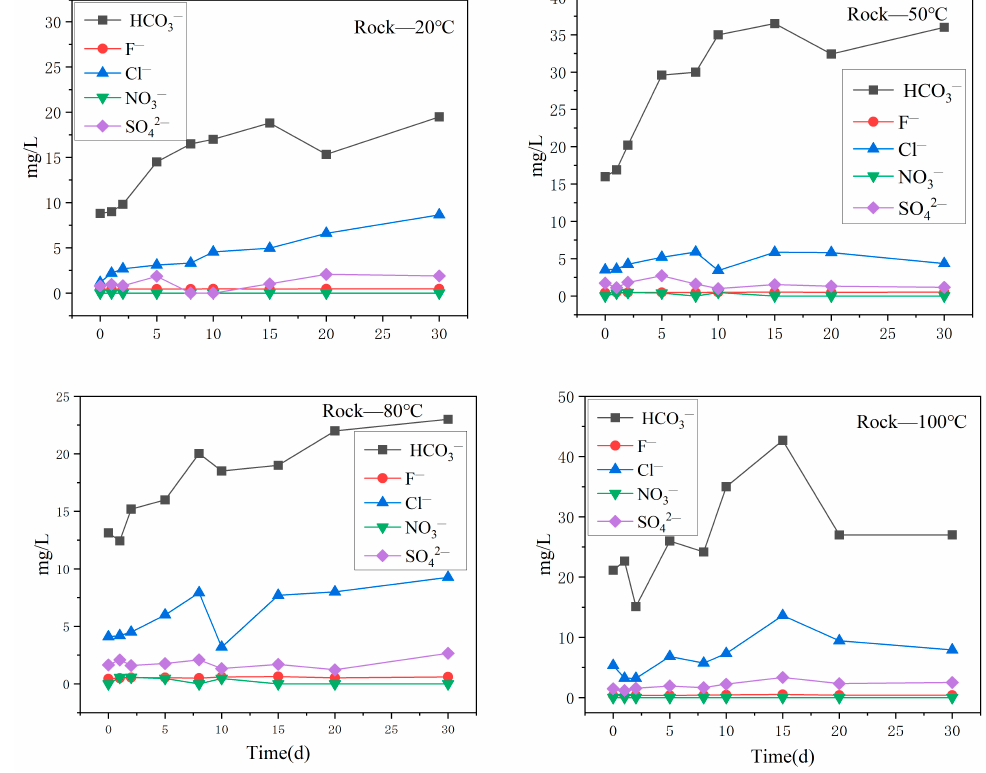
Figure 9. Variation in the content of the main anions in the surrounding rock aqueous solution under different temperature reaction different temperature reaction conditions.